Question: Express in one sentence what the figure is showing.
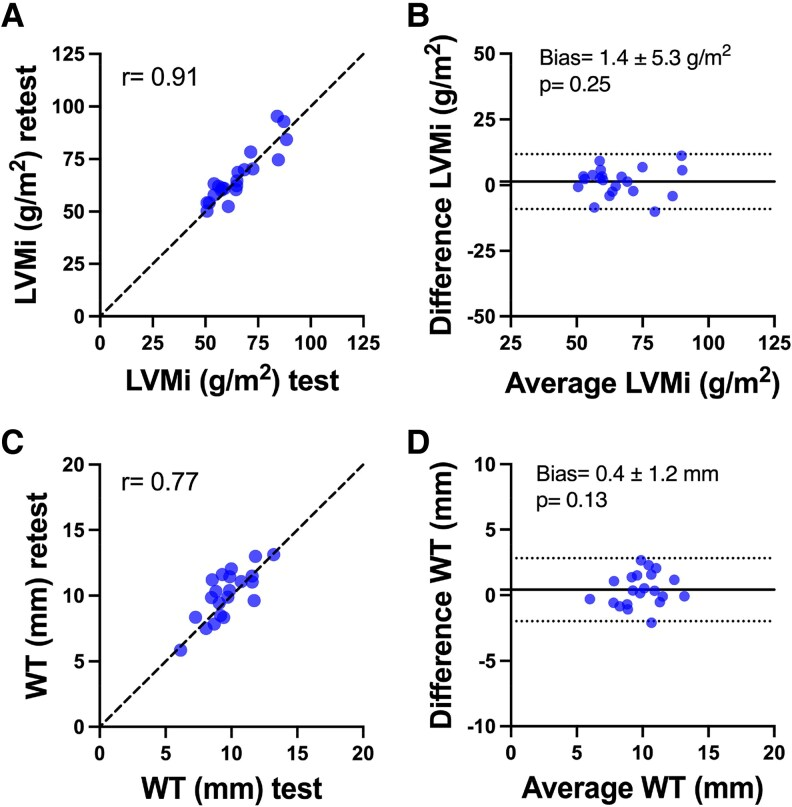
Answer: Test–retest of positron emission tomography left ventricular mass index (LVMi) and interventricular septal wall thickness (WT) in n = 21 patients. Dashed lines are lines of identity ( A , C ), dotted lines represent Bland–Altman 95% limits of agreement ( B , D ), and solid lines represent bias ( B , D ).